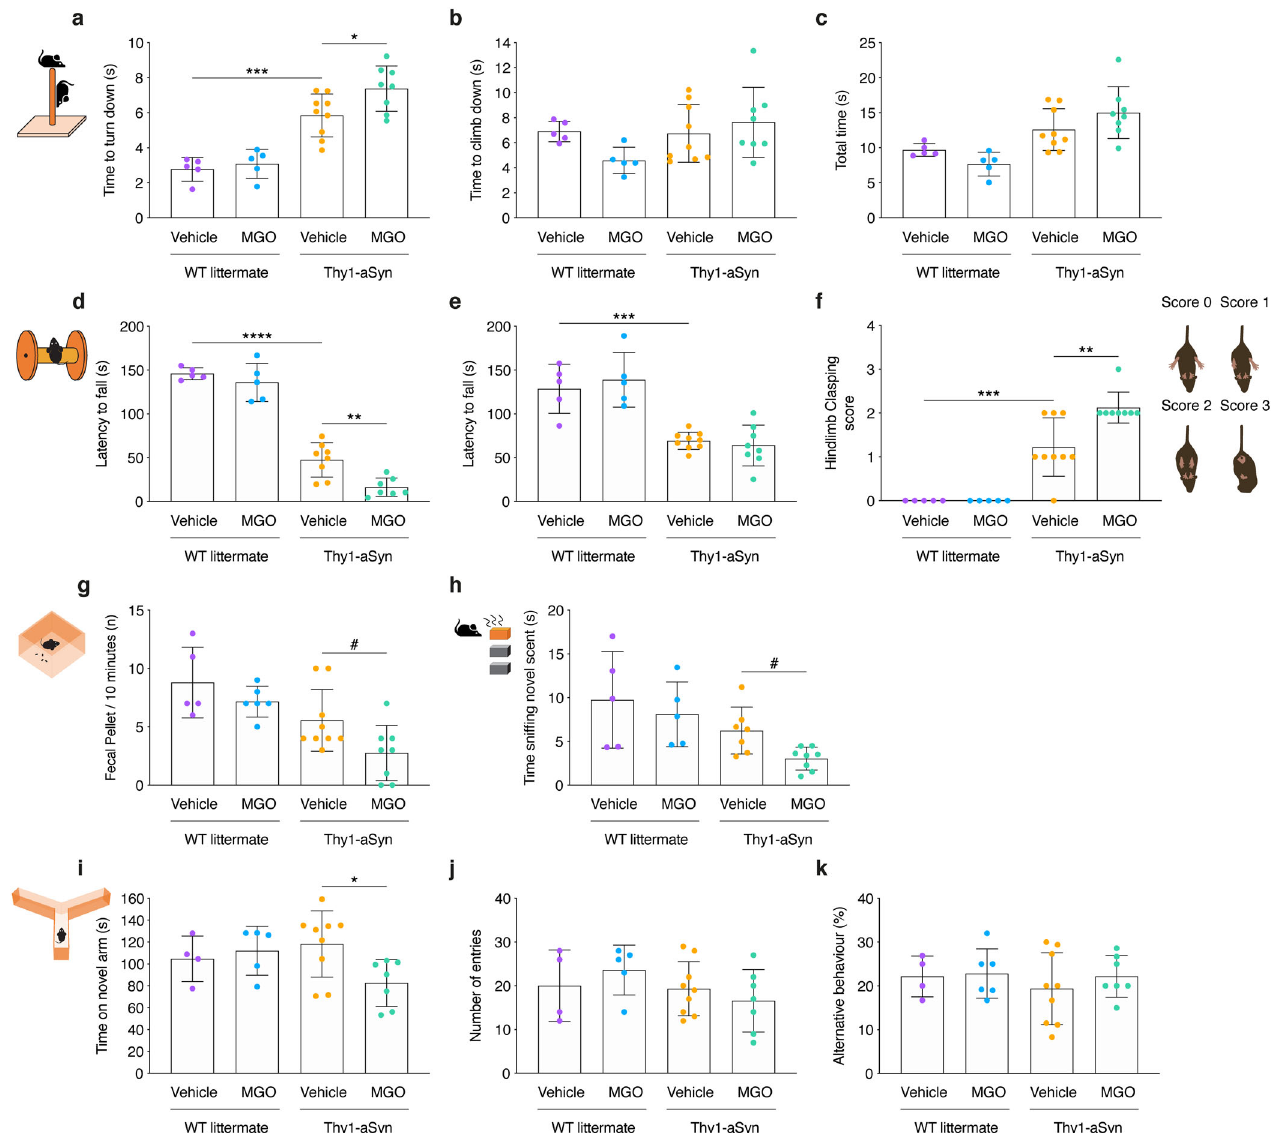
Fig. 1 MGO-treatment induces motor dysfunction, cognitive impairment, olfactory, and colonic disturbances in Thy1-aSyn mice. Wild-type littermate (WT) and Thy1-aSyn transgenic (Tg) mice received an intracerebroventricular (ICV) injection of MGO or vehicle (PBS) at 16 weeks of age. Behavioral testing started 4 weeks post surgery. Plot representations of: pole test — a time to turn down, b time to climb down, c total time; rotarod — d stationary protocol, e acceleration protocol; f hindlimb clasping score; g fecal pellet production; block test — h time snif fi ng novel scent; Y maze test — i time on novel arm, j number of entries, k alternative behavior. At least n = 5 in all groups, data in all panels are average, with error bars representing standard deviation, Ordinary one-way ANOVA, * p < 0.05, ** p < 0.01, *** p < 0.001, **** p < 0.0001; unpaired two-tailed t -test with equal SD, # p <